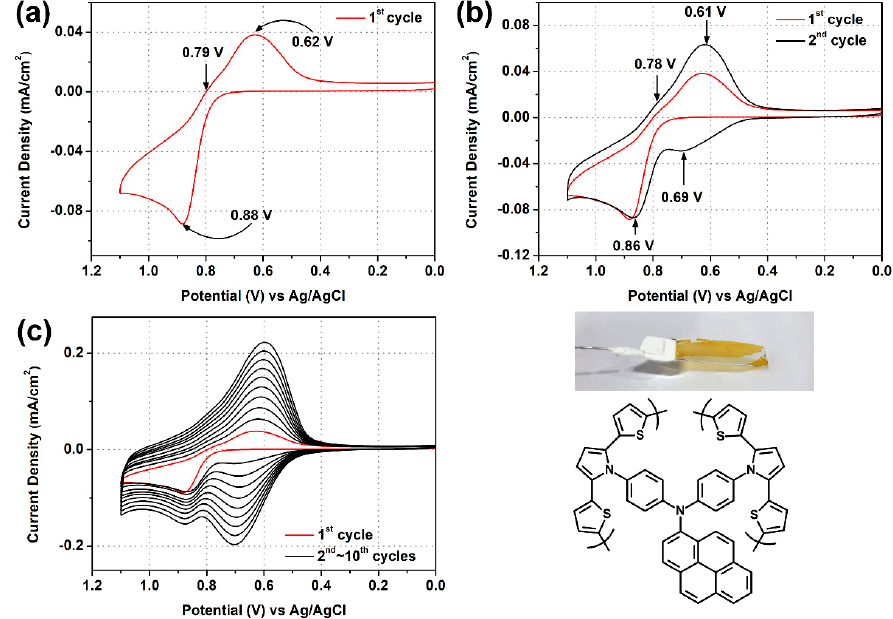
Figure 4. ( a ) The first CV scan, ( b ) the first two second CV scan, and ( c ) ten repetitive CV scans of 0.2 mM of DPPA-2SNS in 0.1 M Bu 4 NClO 4 / CH 2 Cl 2 in the potential range of 0.00–1.10 V at a scan rate of 50 mV/s.